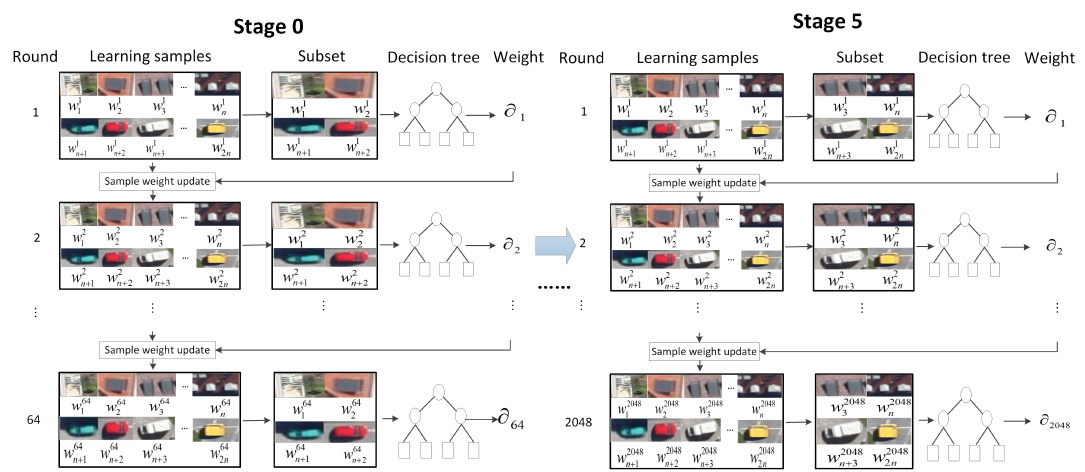
Figure 4. Training process of the cascade of boosted classifiers. We adopt the cascade of six stages, and employ {64, 128, 256, 512, 1024, 2048} weak classifiers in each